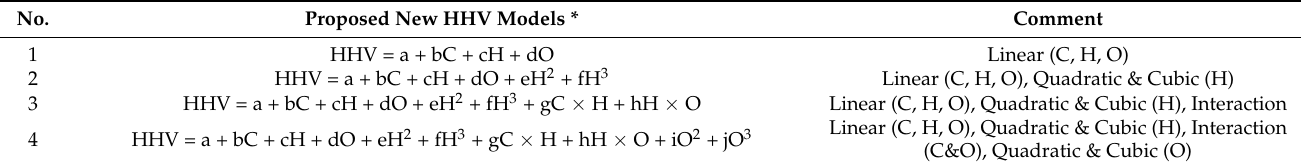
Table 3. Proposed regression models for agricultural crop